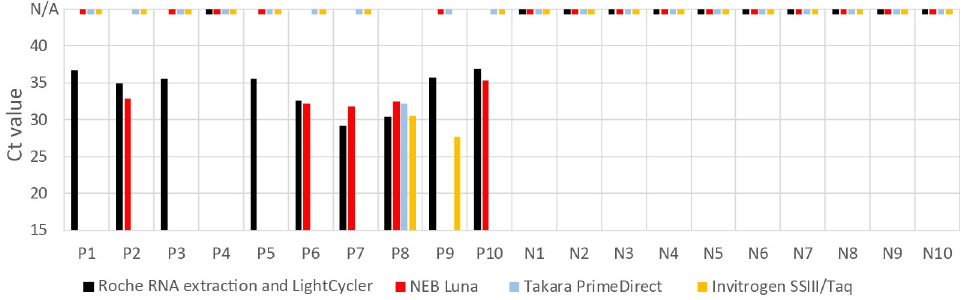
Fig 1. RT-qPCR of 10 previously SARS-CoV-2 positive (P) and 10 previously SARS-CoV-2 negative (N) mouthwashes. RNA was either extracted from 200 μ l of mouthwashes (black bars) or 1 μ l of the mouthwashes was added directly to the RT-qPCR reaction mix without prior extraction (colored bars). Dashes at N/A indicate no amplification of the viral